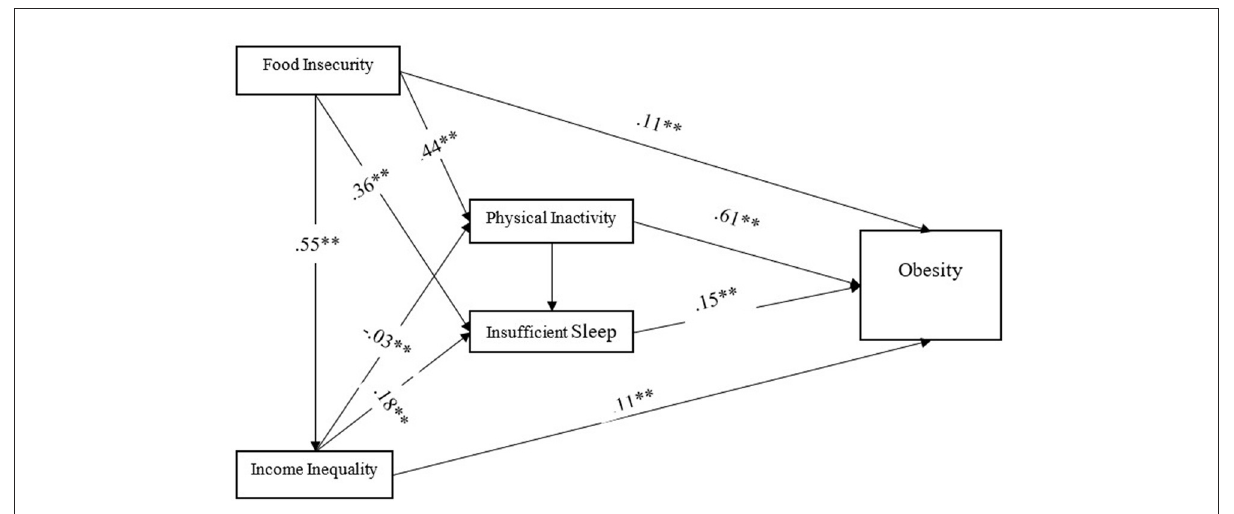
FIGURE1 Path analysis model. N = 3143. ** p < 0.001,